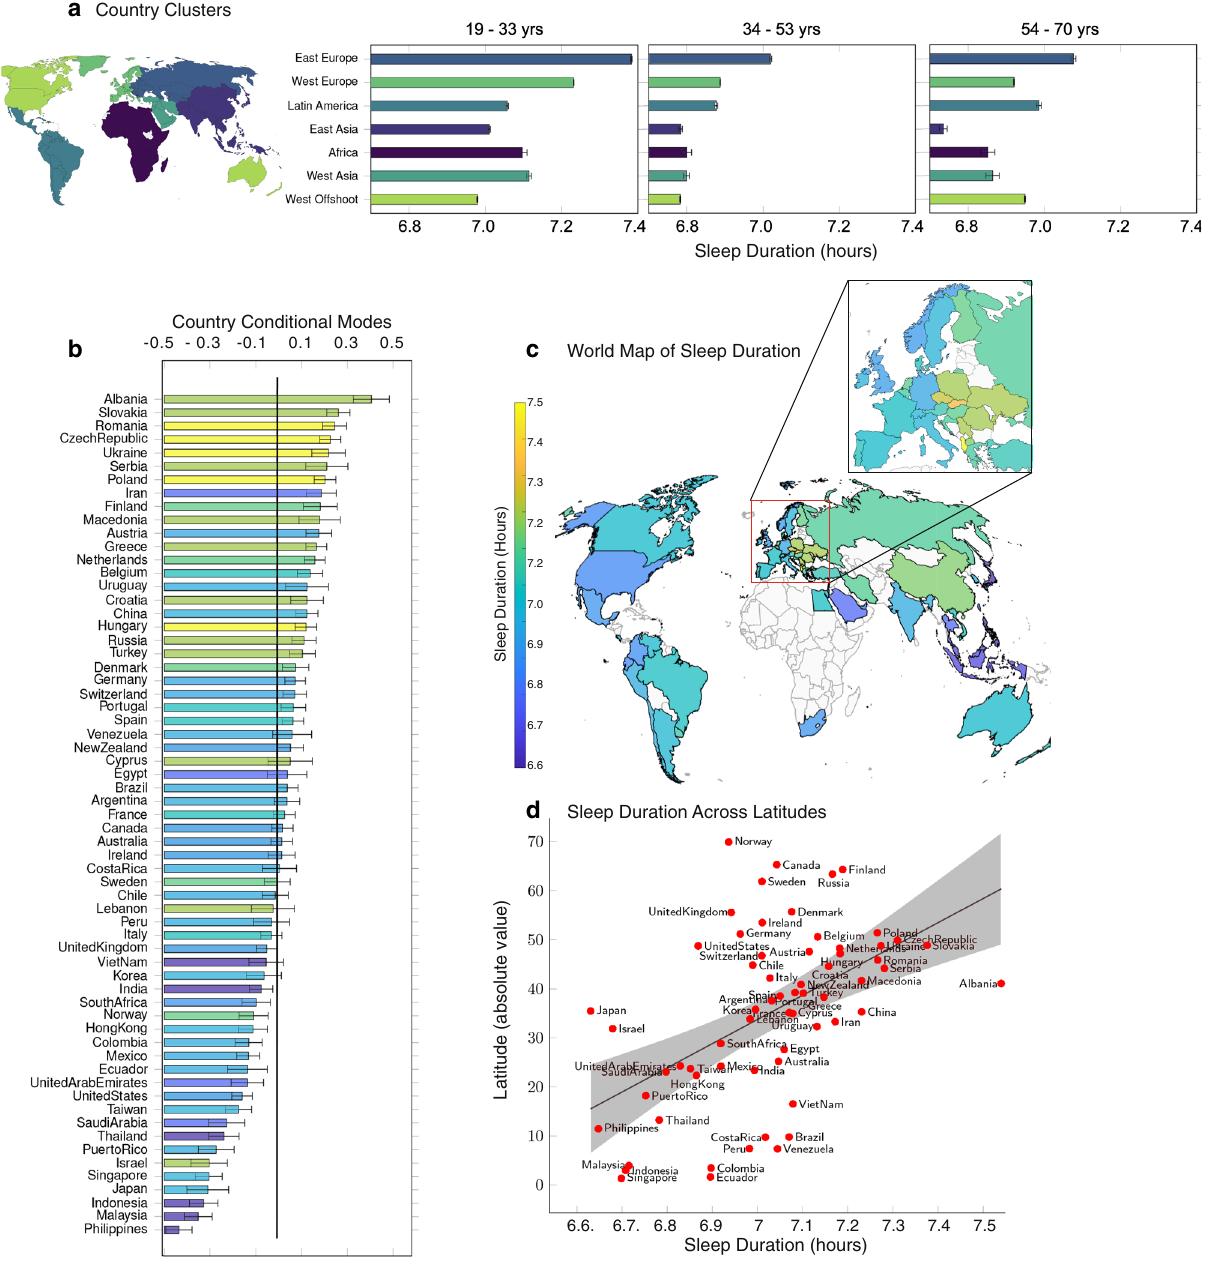
Fig. 3 | Distribution of reported sleep duration across countries. a Reported sleep durations averaged in 7 global clusters of countries de fi ned by Maddison 23 . In the fi rst, second and third age groups, the sample sizes are, respectively, n =321,406, n =263,932 and n =144,849. The samples sizes of the country clusters are available in Supplementary Fig 3. b Random intercepts clustered by countries from a linear-mixed model predicting reported sleep duration with age, age 2 ,